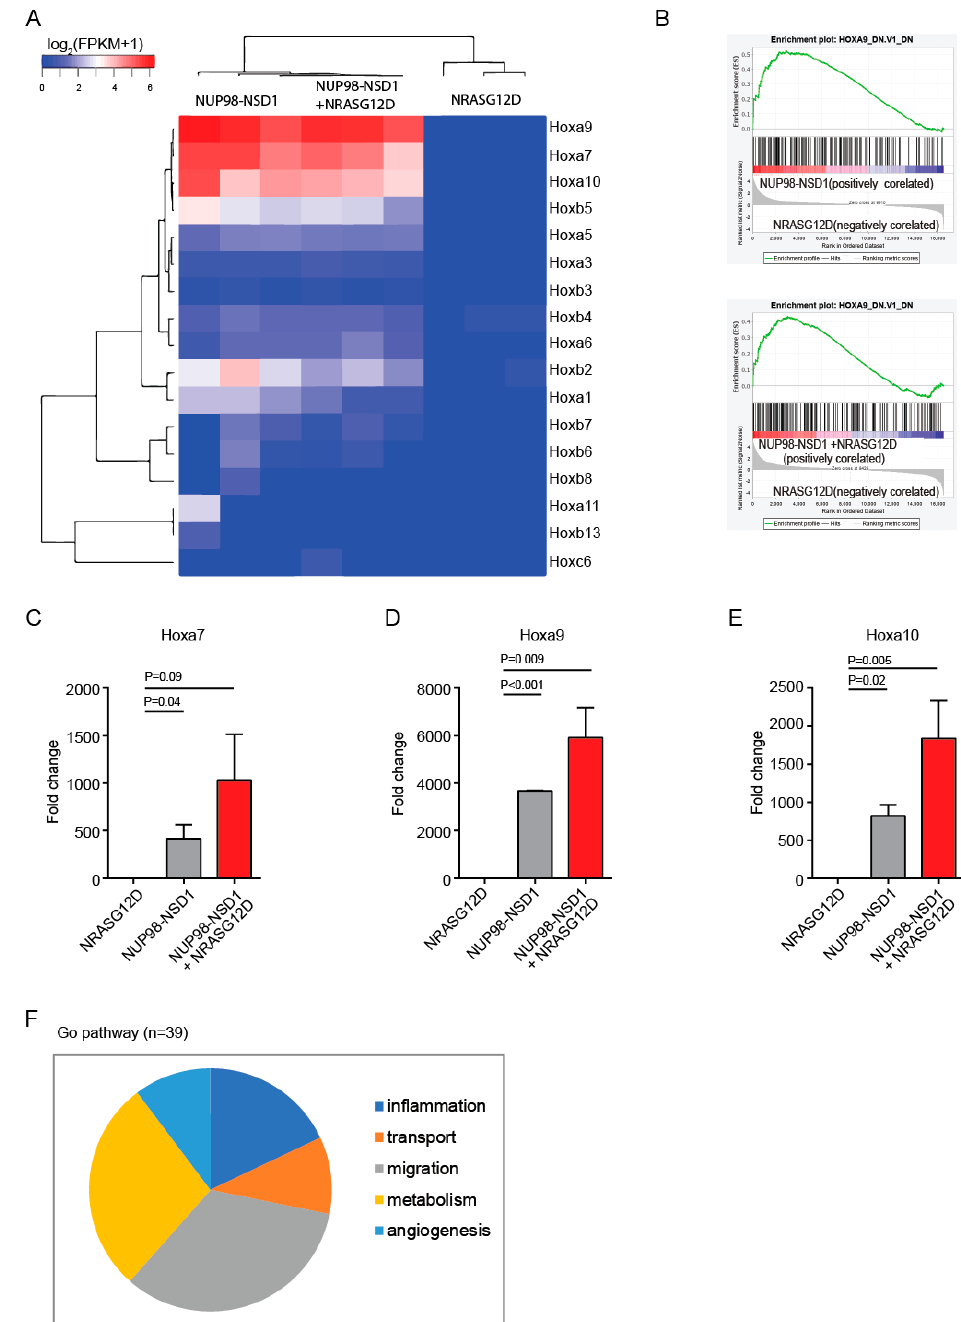
Figure 3. Common and distinct pathways are regulated by NUP98-NSD1 and NRASG12D. ( A ) Heat map from hierarchical clustering showing differential expression of HOX genes in NRASG12D, NUP98-NSD1, and NUP98-NSD1 + NRASG12D transformed cells. ( B ) Enrichment plot for the gene sets HOXA9_DN.V1_DN of Gene Set Enrichment Analysis (GSEA) comparing NUP98-NSD1 and NRASG12D transformed cells. ( C ) Quantitative RT-PCR of Hoxa7 in NRASG12D, NUP98-NSD1, and NUP98-NSD1+NRASG12D transformed mouse bone marrow cells (mean ± SEM). ( D ) Quantitative RT-PCR of Hoxa9 in NRASG12D, NUP98-NSD1, and NUP98-NSD1+NRASG12D transformed mouse bone marrow cells (mean ± SEM). ( E ) Quantitative RT-PCR of Hoxa10 in NRASG12D, NUP98-NSD1, and NUP98-NSD1+NRASG12D transformed mouse bone marrow cells (mean ± SEM). ( F ) Pie chart showing the top 39 biological categories regulated by NRASG12D from the GO biological process pathway gene set analysis comparing NUP98-NSD1 + NRASG12D with